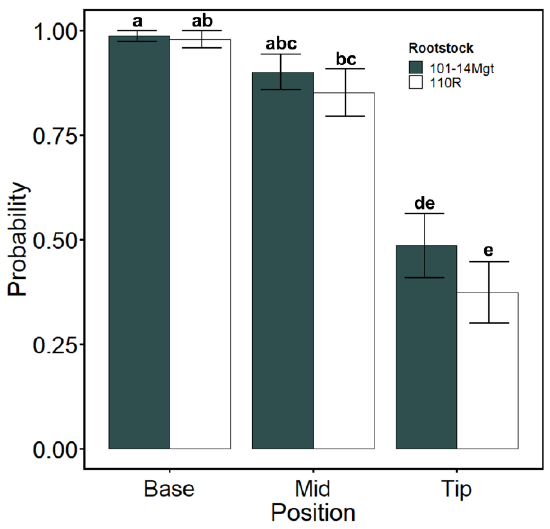
Figure 4. Estimated means probabilities of lacunae formation. Data are means ± SE. Different letters indicate significant differences with 95% confidence level.